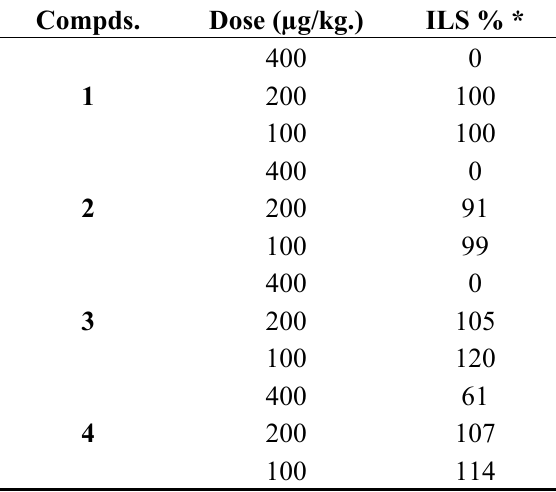
Table 2. Anticancer activity of some selected compounds against leukemia L-1210. Compds. Dose